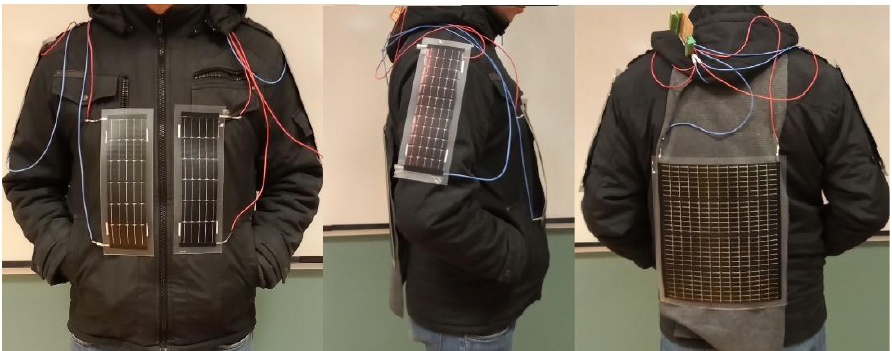
Figure 8. PV module configuration for a jacket.